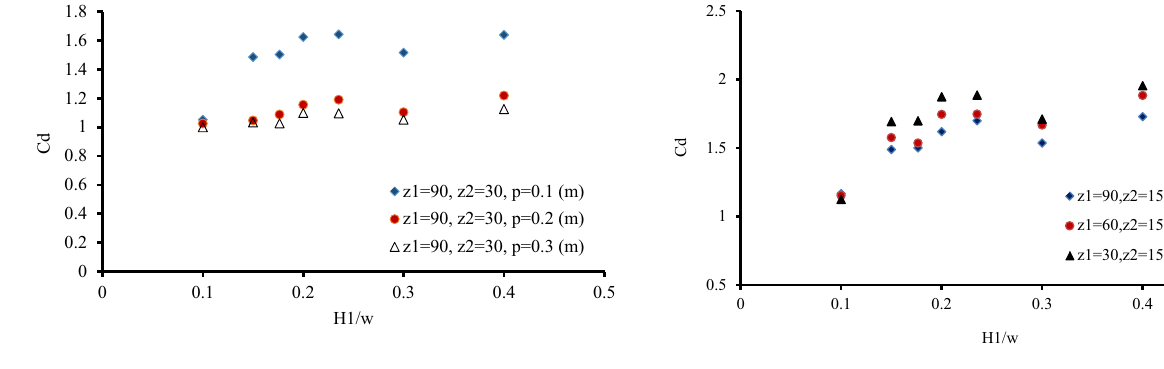
p = 0.1 m and for different 2 = 15°,